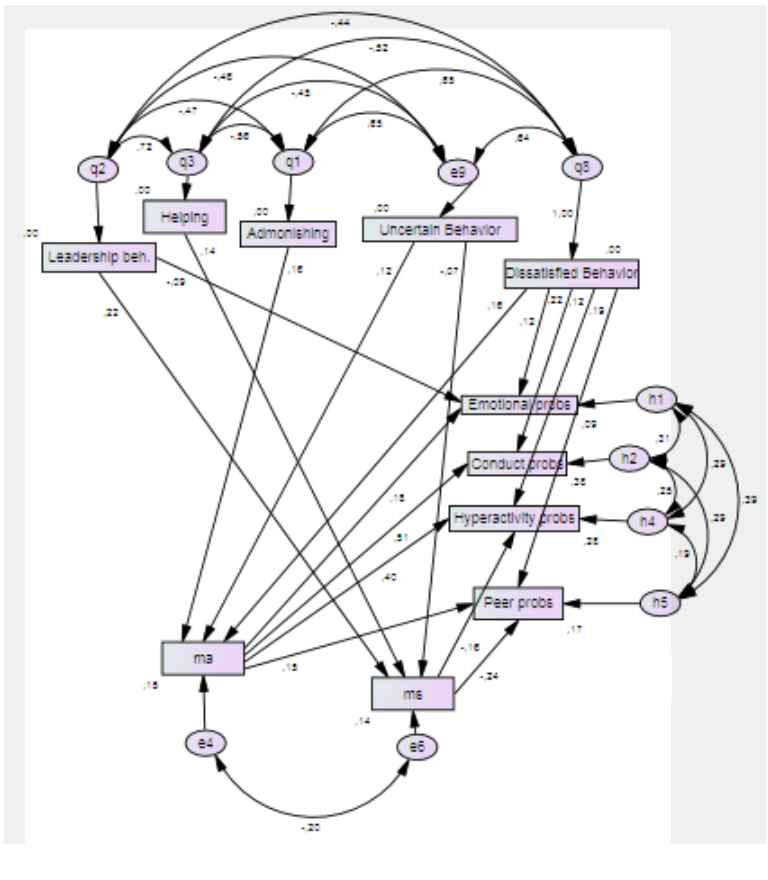
Figure 3. Model the effects on students’ emotional and behavioural difficulties (leadership behaviour, helping/friendly behaviour, admonishing behaviour, uncertain behaviour, dissatisfied behaviour, ma=inappropriate assertiveness, ms=appropriate social skills, emotional problems, conduct problems, hyperactivity, peer